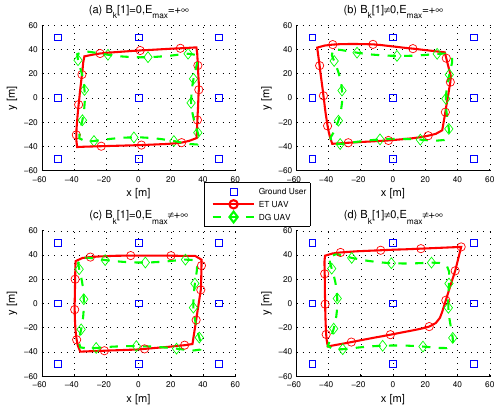
Figure 4. Optimized UAV trajectories when T = 60 s.